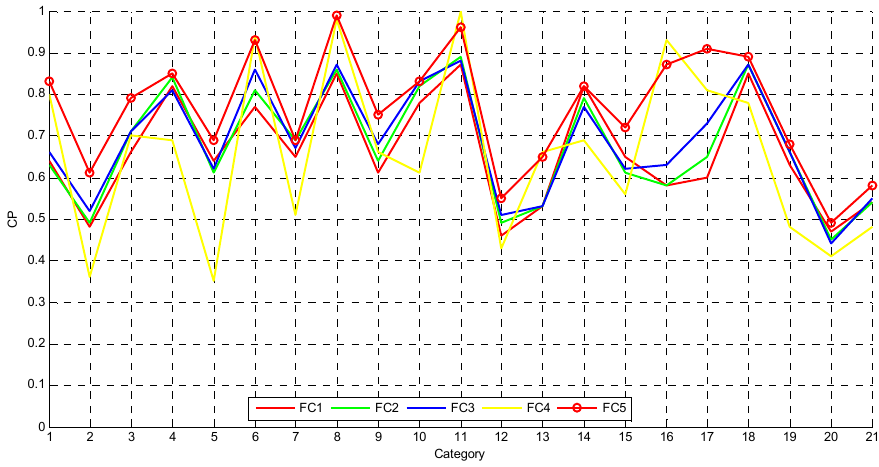
Figure 5. Class-level precision (CP) using different feature combinations.